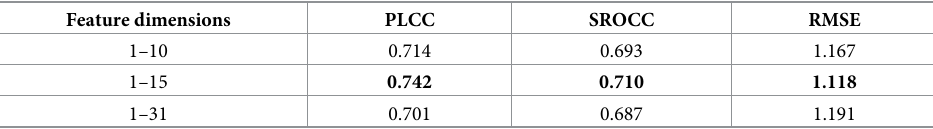
Table 4. Performance comparison with features of different